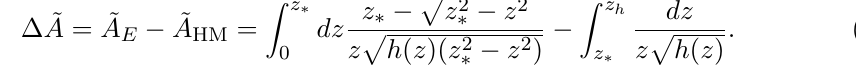
Figure 8 . A numerical plot of the area difference ∆ as a function of the endpoint of R ( t confirms that the Hartman-Maldacena surface is minimal at t